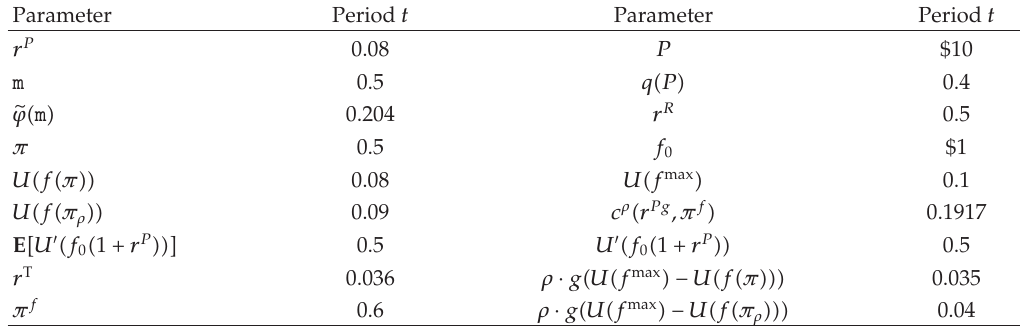
Table 2: Numerical example involving subprime structured mortgage